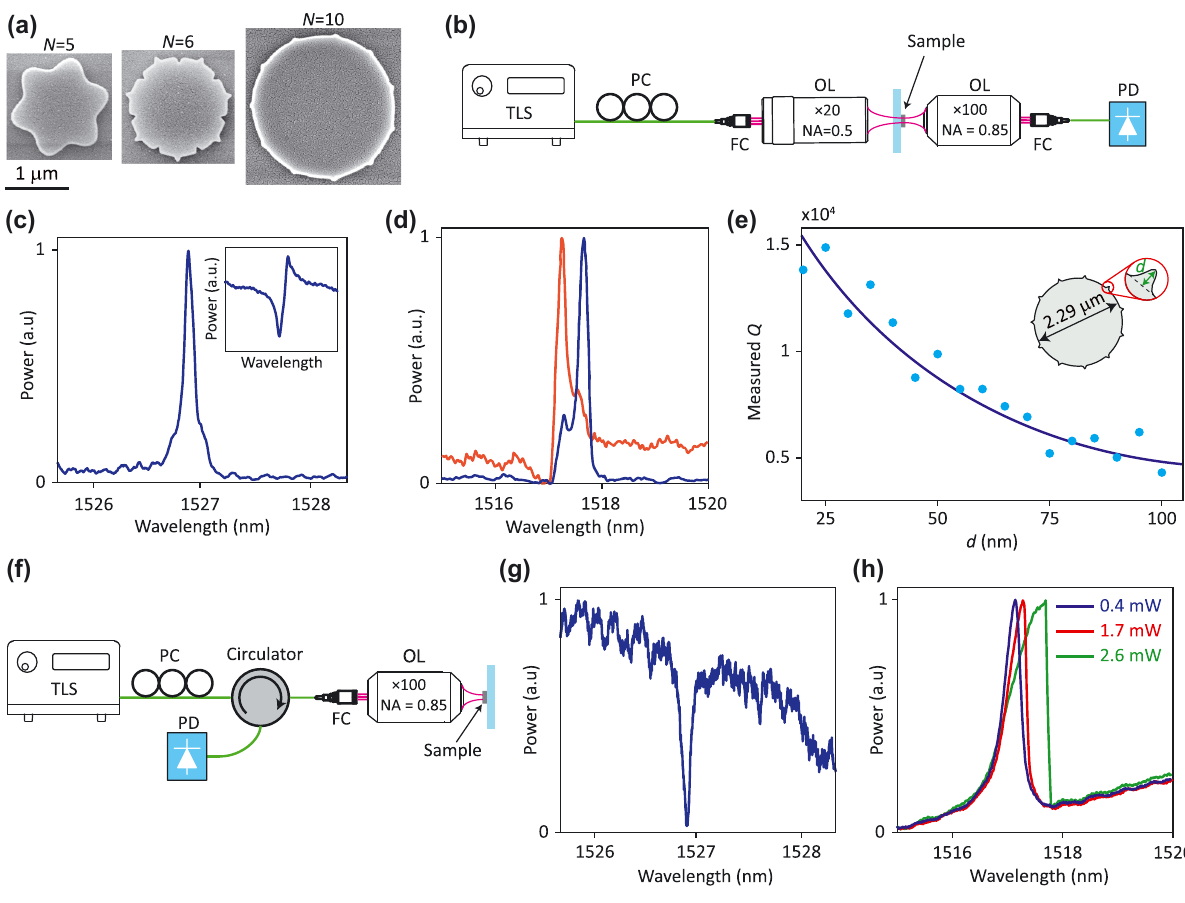
Figure 3: Exprimental